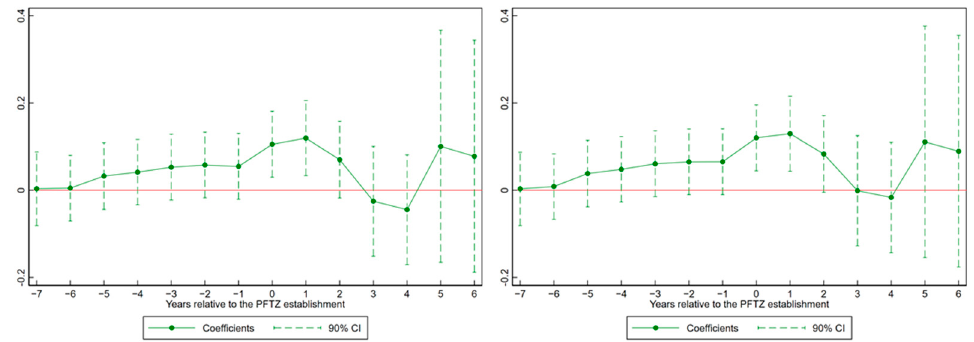
Figure 4. Parallel trend test. Without (left) and with (right) control variables.